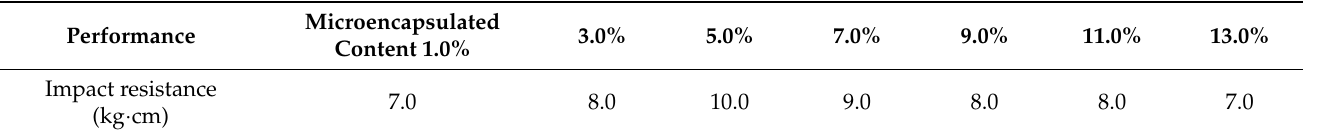
Table 7. Effect of the content of colour–changing powder microcapsules on the impact resistance of topcoat paint